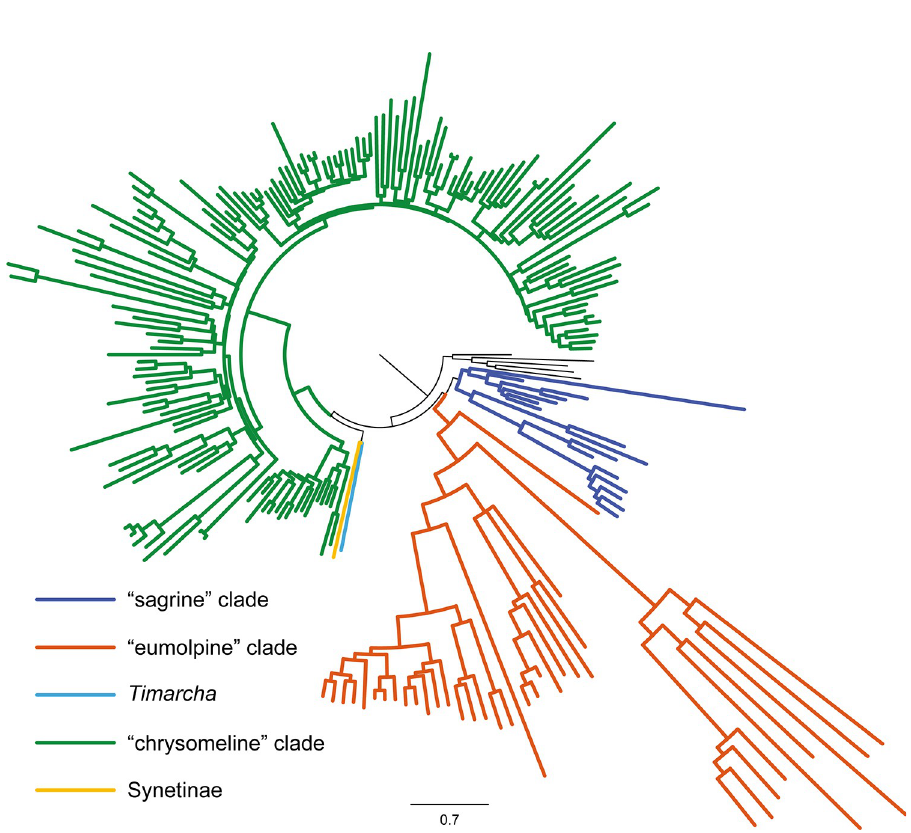
Fig 5. Bayesian tree inferred from the dataset PCGnt+RNA using PhyloBayes under the site-heterogeneous CAT-GTR model. The full tree with all branches is available in S8 Fig.